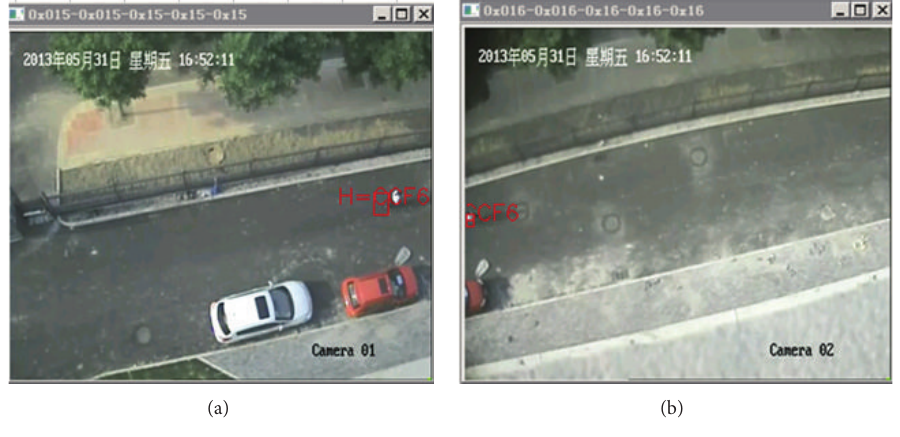
Figure 10: The continuous tracking results between camera 1 and camera 2.